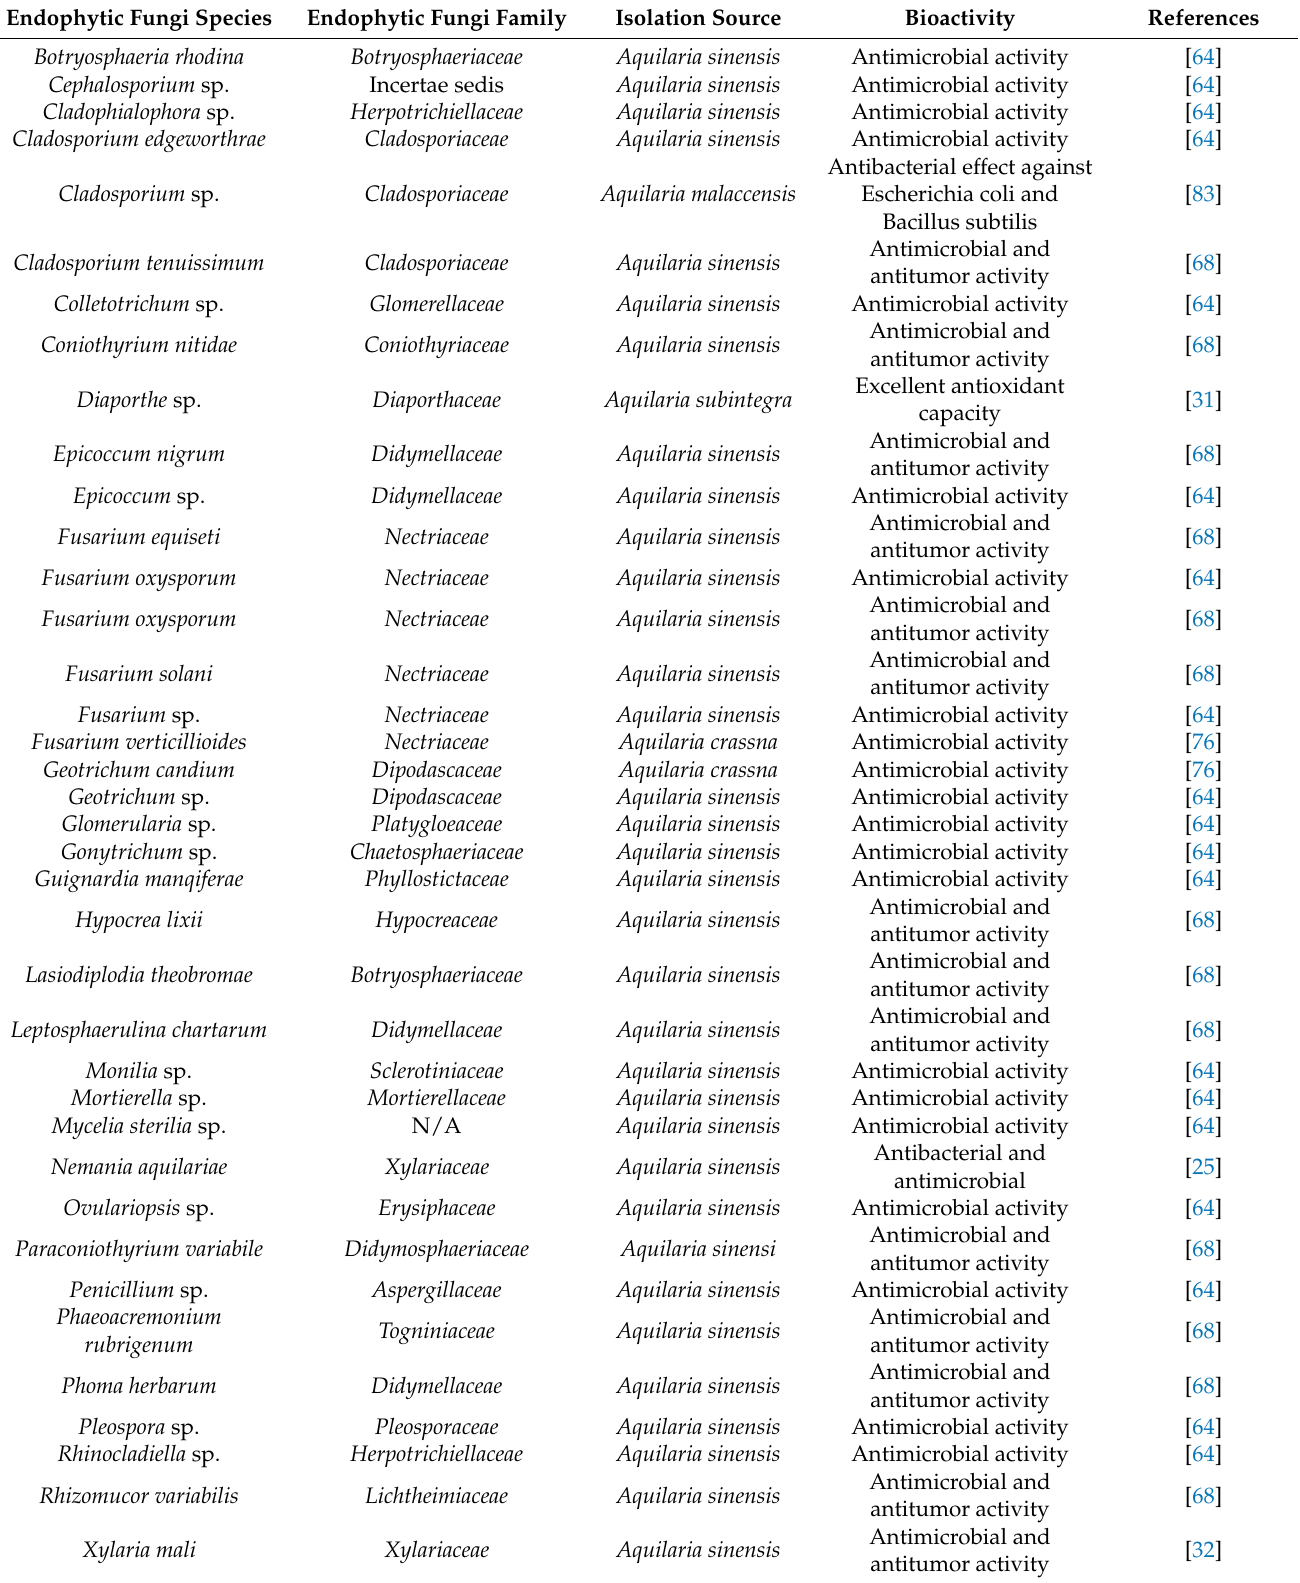
Table 3. Bioactivity of endophytic fungi isolated from agarwood-producing trees. “N/A” indicates no information